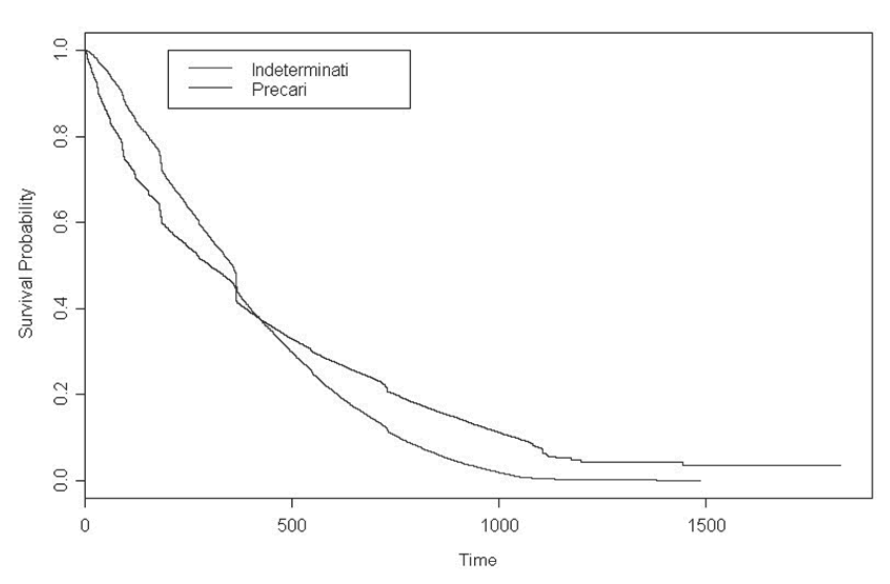
Figure 5 – Survival curves for job placements on temporary contracts, according to the type of final control (2004-2006). [Indeterminati – permanent contracts. Precari – flexible/temp. contracts] Source: Elaboration of SILER data – Province of